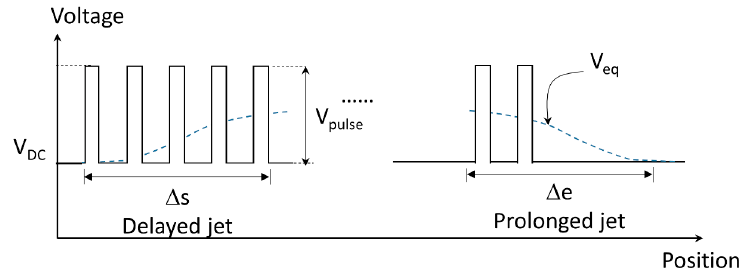
Figure 13. Effect of transient equivalent DC voltage.